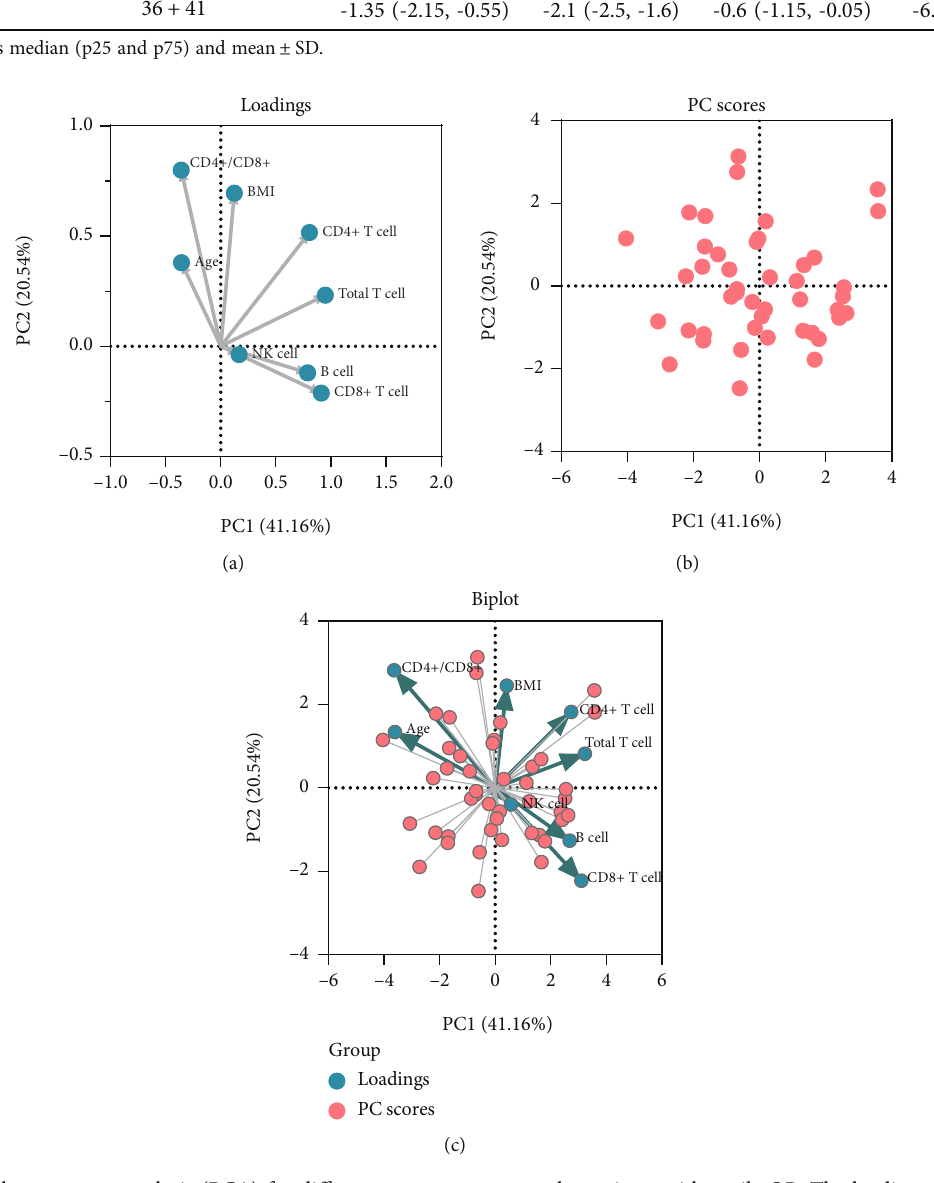
Figure 1: Principal component analysis (PCA) for di ff erent measurements on the patients with senile OP. The loading plot depicted the correlation of eight measurements and showed that age was associated with PC2. The absolute counts of CD8 + T lymphocytes were correlated with PC1 (a). The PC score plot showed that the data from 44 patients with OP were signi fi cant (b). Finally, a biplot was used to show both the loadings and PC scores (c).